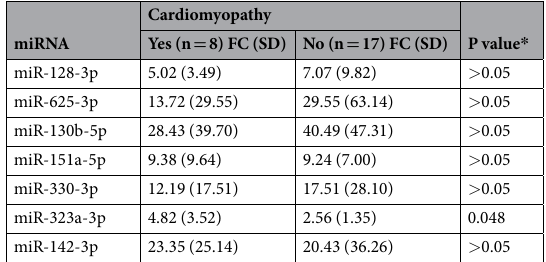
Table 3. Expression levels of selected miRNAs in FRDA cases. * Statistically significant differences were determined using Mann-Whitney tests. All P-values were two-tailed and less than 0.05 was considered statistically